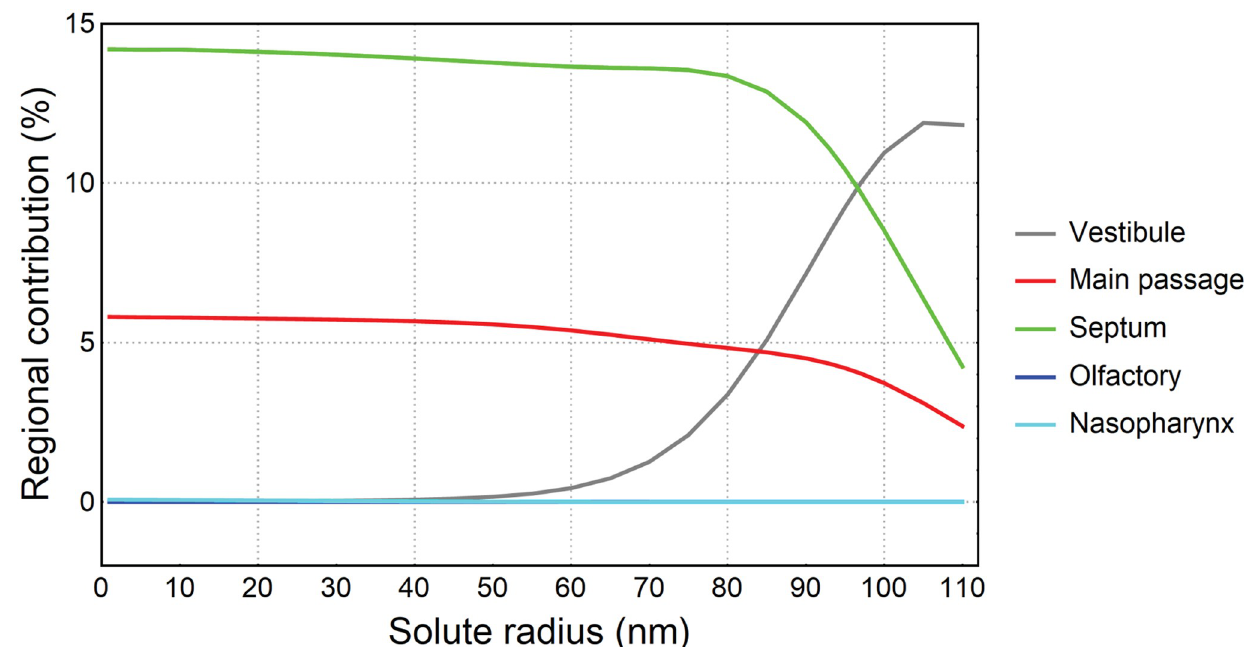
Fig 10. Total drug absorption produced from initial deposition regions, for different solute